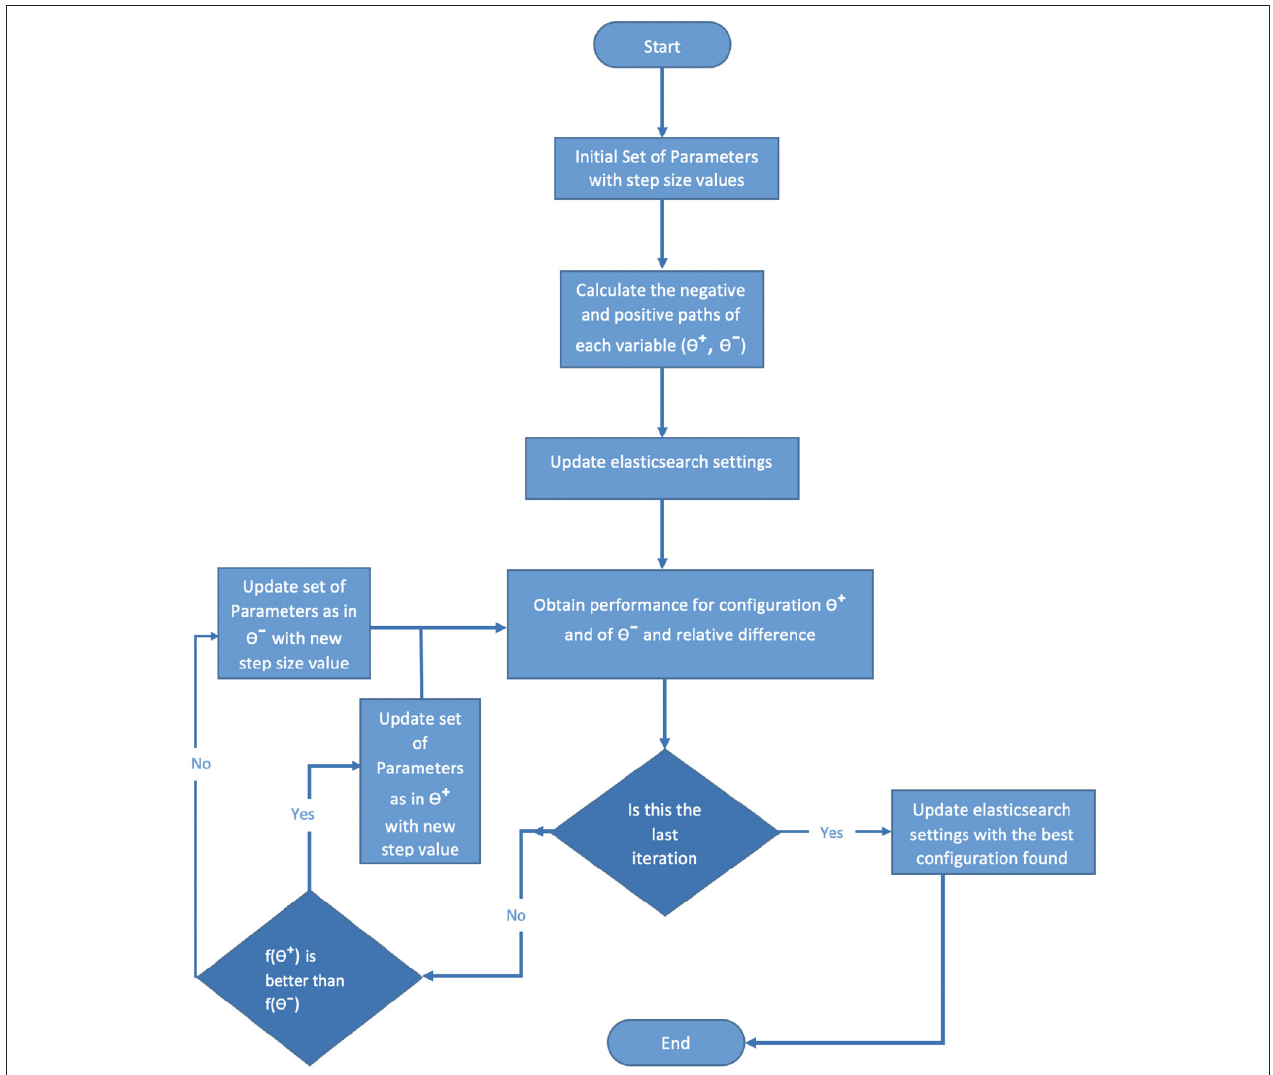
FIGURE 5 | Optimizer algorithm data